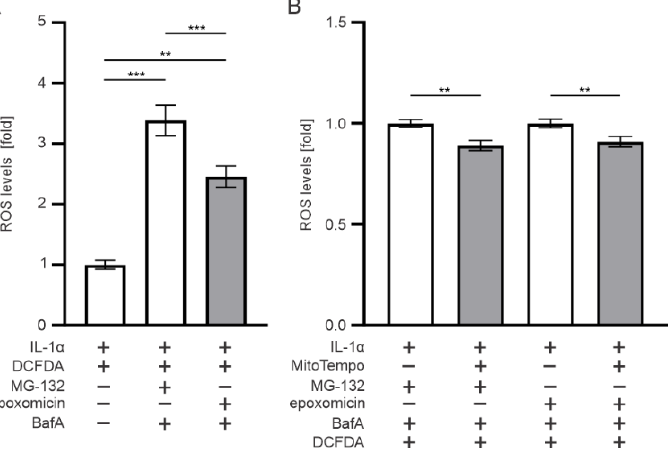
Figure 8. ( A ) ROS levels in APRE-19 cells exposed to epoxomicin or MG-132 with BafA; ( B ) cell viability and ROS levels under similar conditions with MitoTempo. Data of ROS and LDH were combined from at least four independent experiments, with four parallel samples in each group. The results are presented as mean ± SEM. ** p ≤ 0.01, *** p ≤ 0.001 .